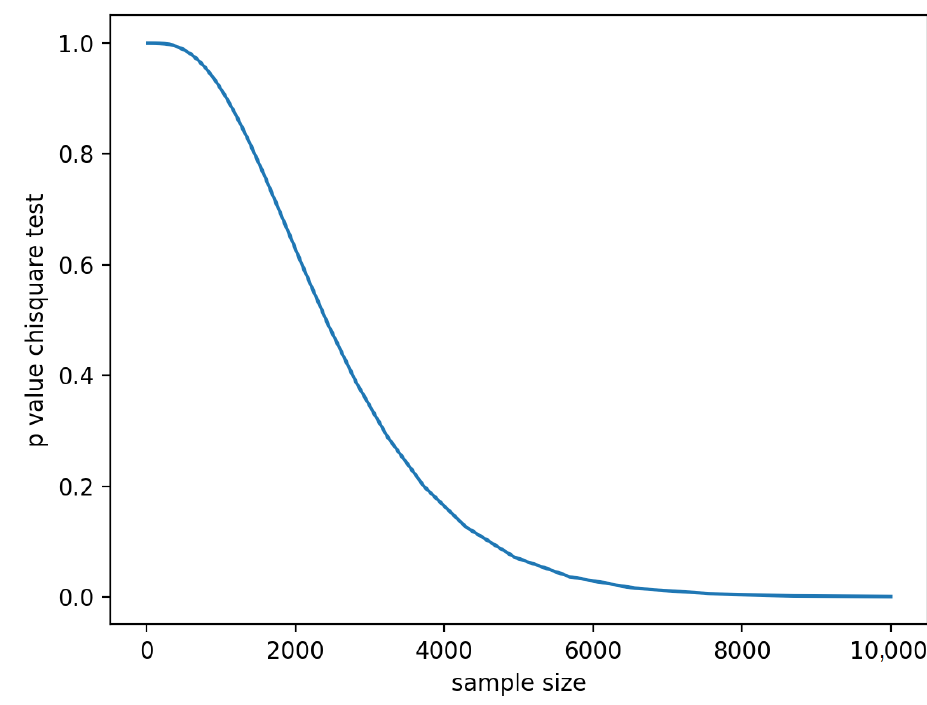
Figure 4. The χ 2 test conducted to test the null hypothesis of the generated distribution to be independent and identically distributed independent and identically distributed like the target distribution. The plot is created by testing like the target distribution. The plot is created by testing samples taken from the same generated distribution against the same target samples taken from the same generated distribution against the same target distribution, and varying the number of samples s distribution, and varying the number of samples s .